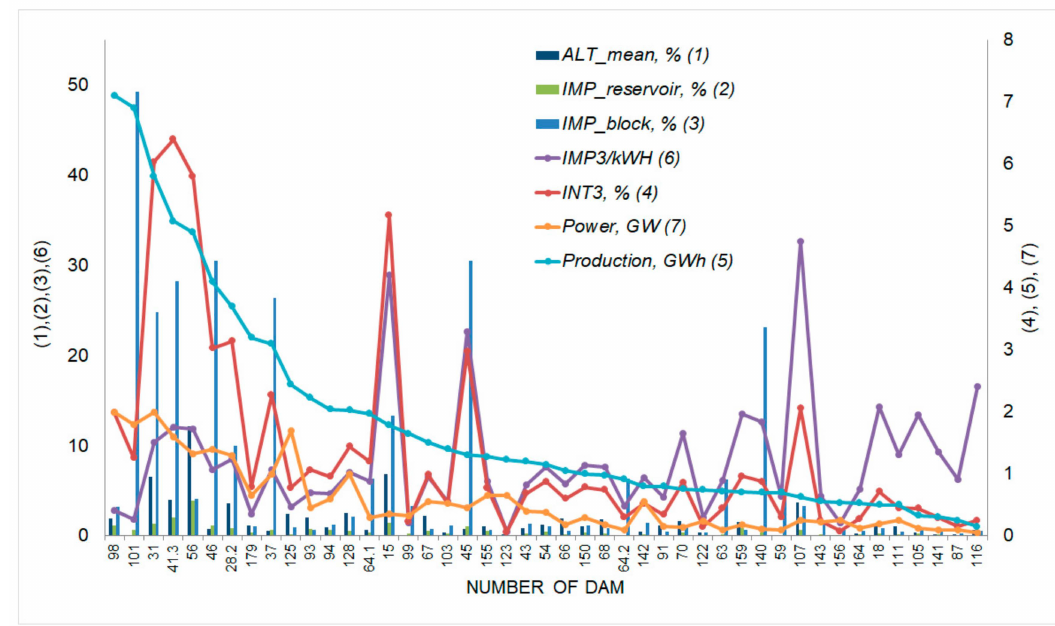
Figure 3. Impact of individual hydropower